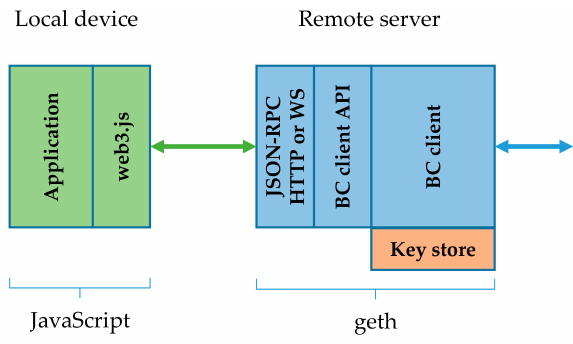
Figure 3. Remote geth client with remote key store